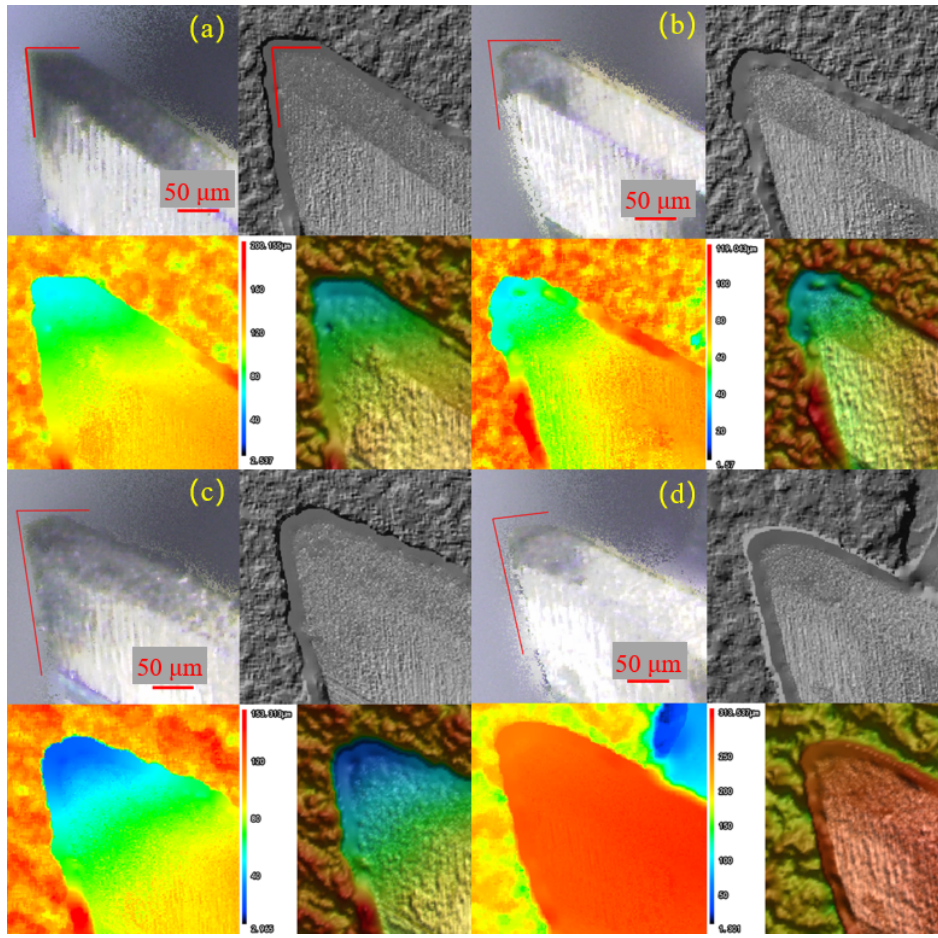
Figure 9. Analysis and three-dimensional topography of tool surface wear under different wear states. ( a ) Initial’s confocal microscopic image, ( b ) Wear I’s confocal microscopic image, ( c ) Wear II’s confocal microscopic image and ( d ) Wear III’s confocal microscopic image.